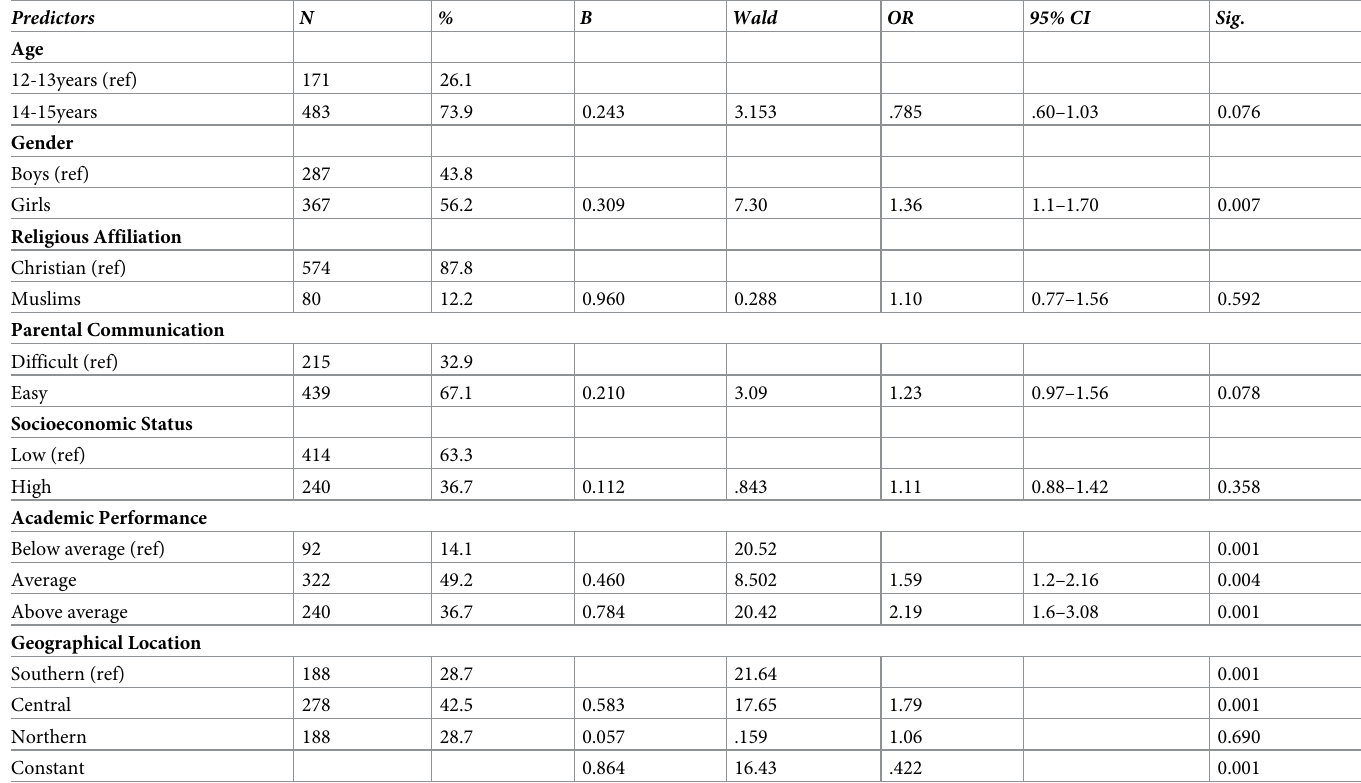
Table 3. Binary logistic regression of socio-demographic predictors of healthy dietary practices among in-school adolescents.